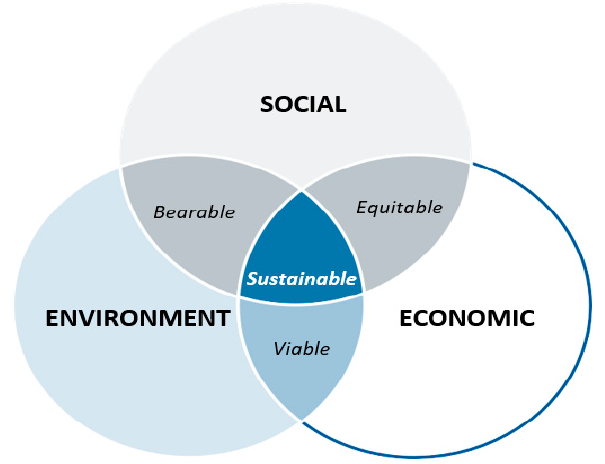
Figure 3. Sustainable development [28].